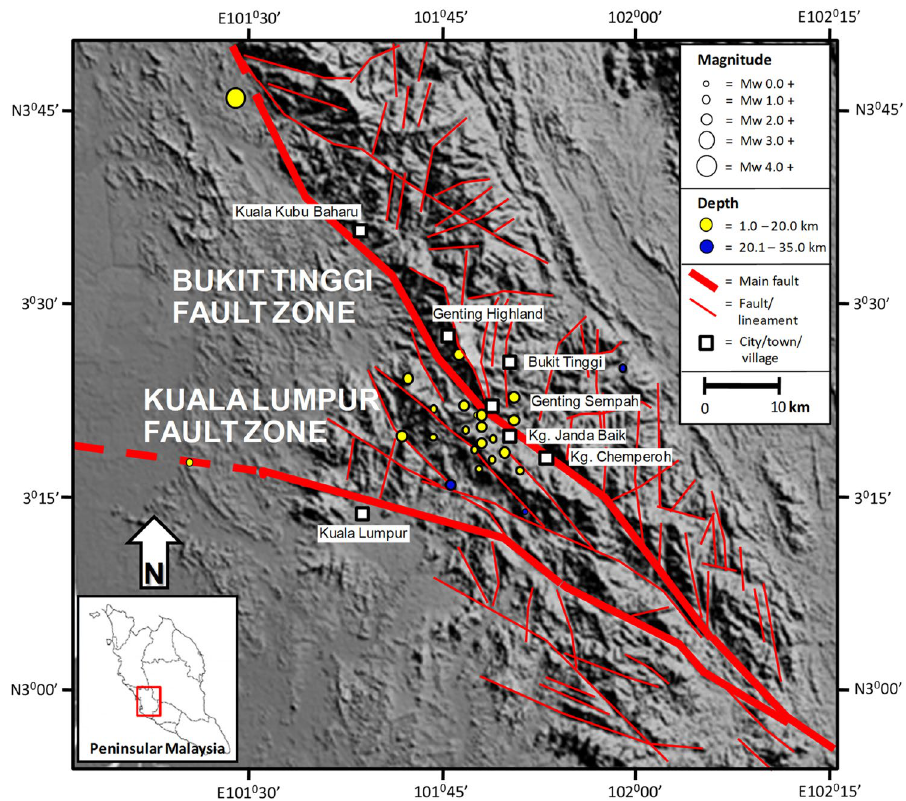
Fig. 6 SRTM–DEM image of Bukit Tinggiand Kuala Lumpur Fault Zones with the earth- quake distribution in between and around these two most active seismogenic faults in Peninsular Malaysia. Red thicker lines indicate main known faults; while red thinner lines are lineaments indicating possible faults. Note: Created with